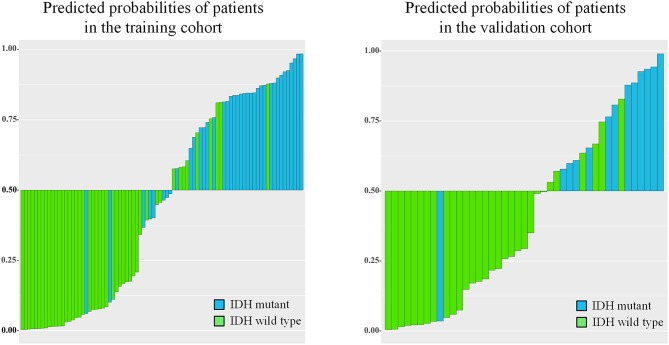
Barplots depicting the predictive performance of the combined model. A blue bar with a predicted probability value > cutoff (0.5) indicates that the model successfully identifies the IDH mutant patients; a blue bar with a predicted value < cutoff indicates that the signature fails to identify the IDH mutant patients. For the green bars, the opposite applies.